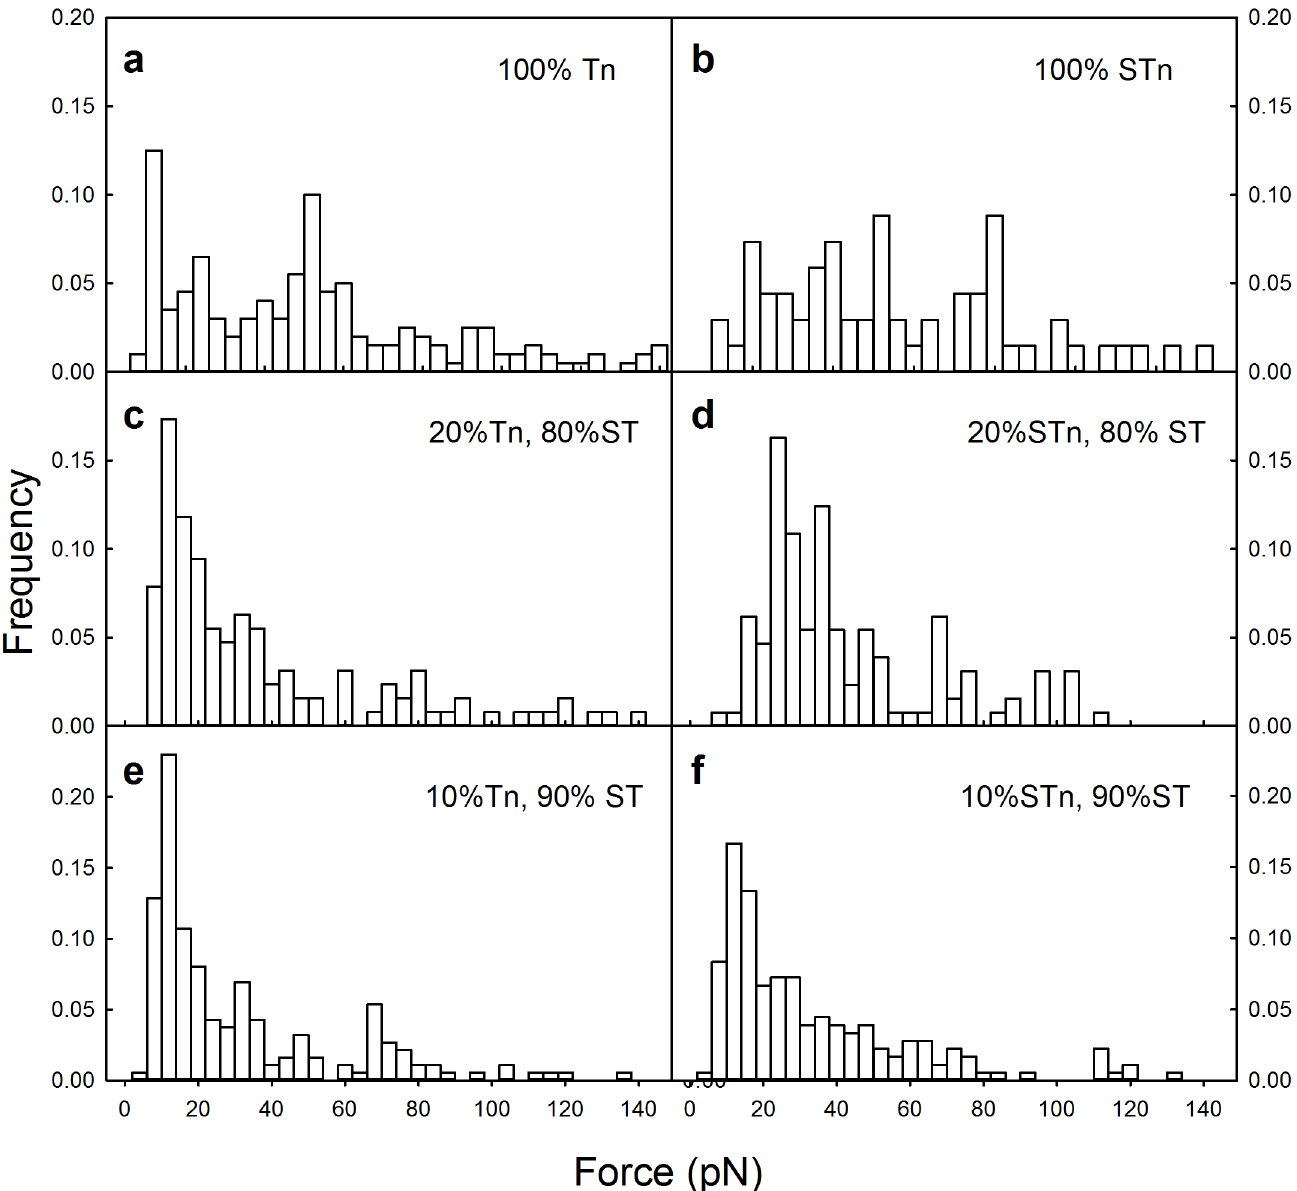
Fig 2. Distributions of intermolecular rupture events betweenMUC1 mucins and MGL obtainedin optical tweezer experiments using polystyrene beadsfunctionalized with MUC1(Tn) (a) and MUC1(STn) (b), mixture of 80% MUC1(ST) and 20% MUC1(Tn) (c) or MUC1(STn) (d) or a mixture of 90% MUC1(ST) and 10% MUC1(Tn) (e) or MUC1(STn) (f). For each of the six experimental series around150 forced rupture events were collected and includedin the analysis.